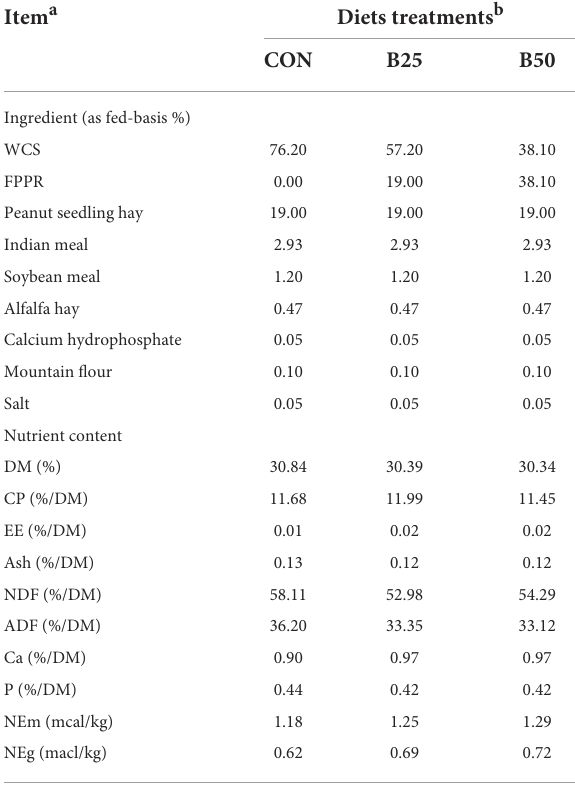
TABLE 1 The ingredients and chemical composition of the